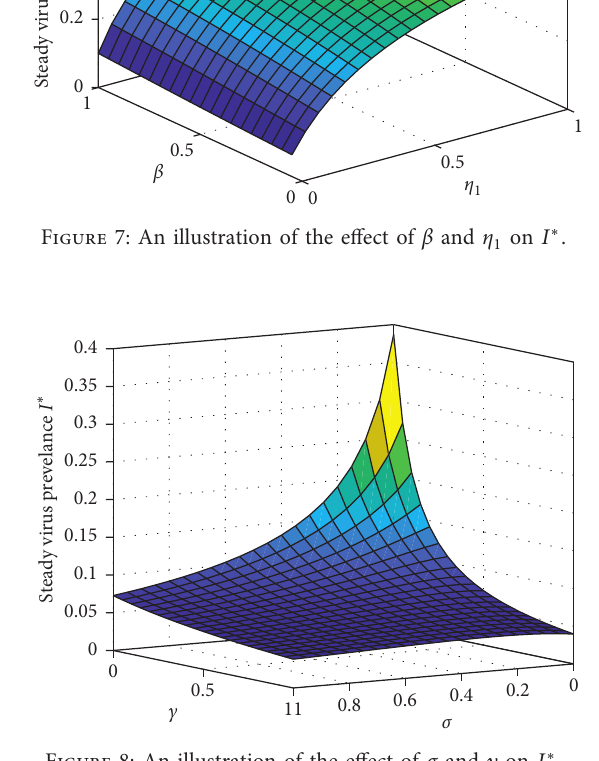
Figure 8: An illustration of the effect of σ and c on I ∗ .